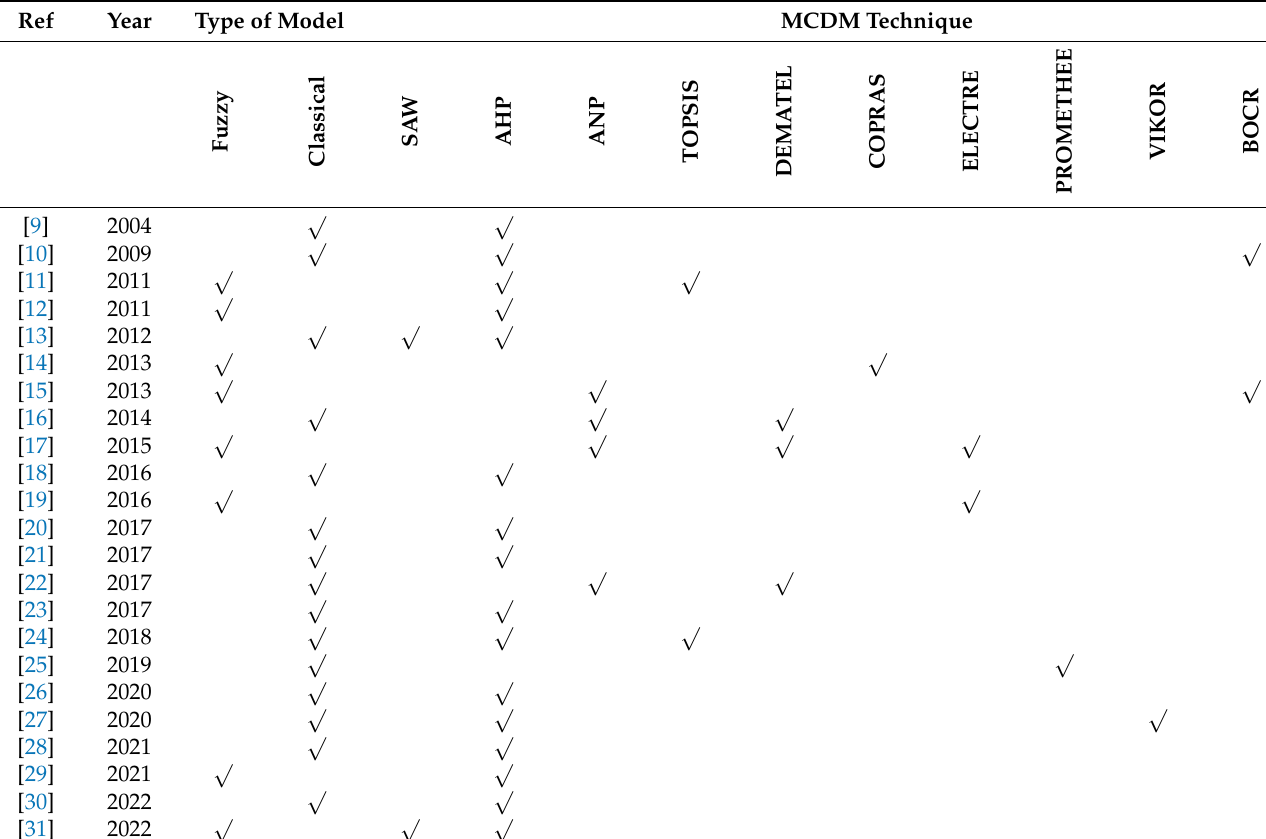
Table 1. A review of the MCDM methods applied to solve the wind farm site selection